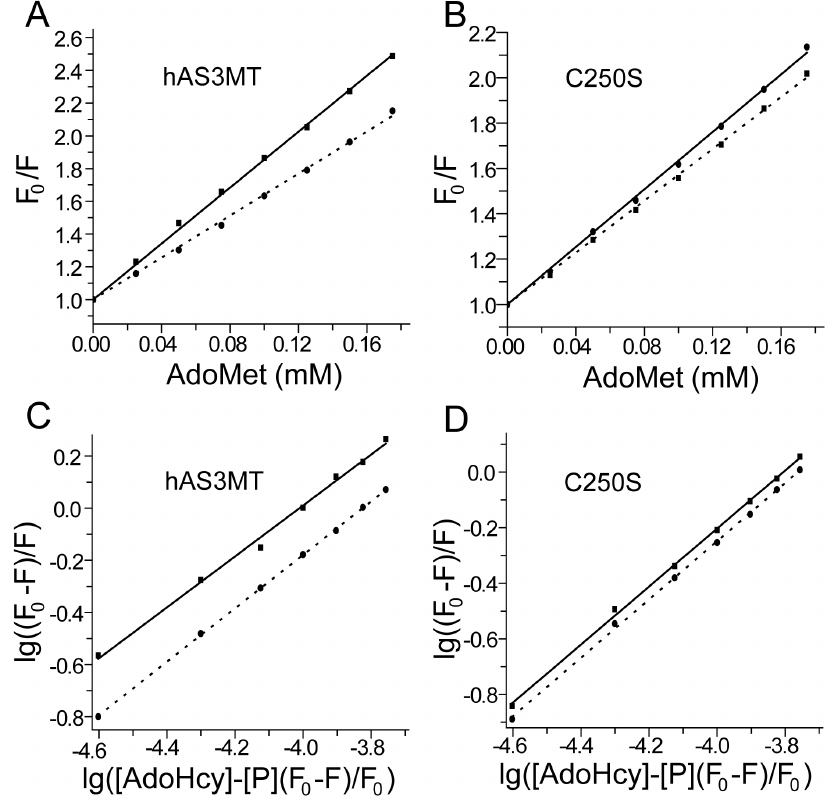
Figure 7. Fluorescence quenching of hAS3MT/C250S with AdoMet. (A, B) Stern-Volmer curves and (C, D) Double logarithm curves for the fluorescence quenching of hAS3MT and C250S with AdoMet at 350 nm, Ex: 276 nm. Solid line and dot line respectively represent the temperature at 27 u C and 37 u C. Each experiment was carried out three times.